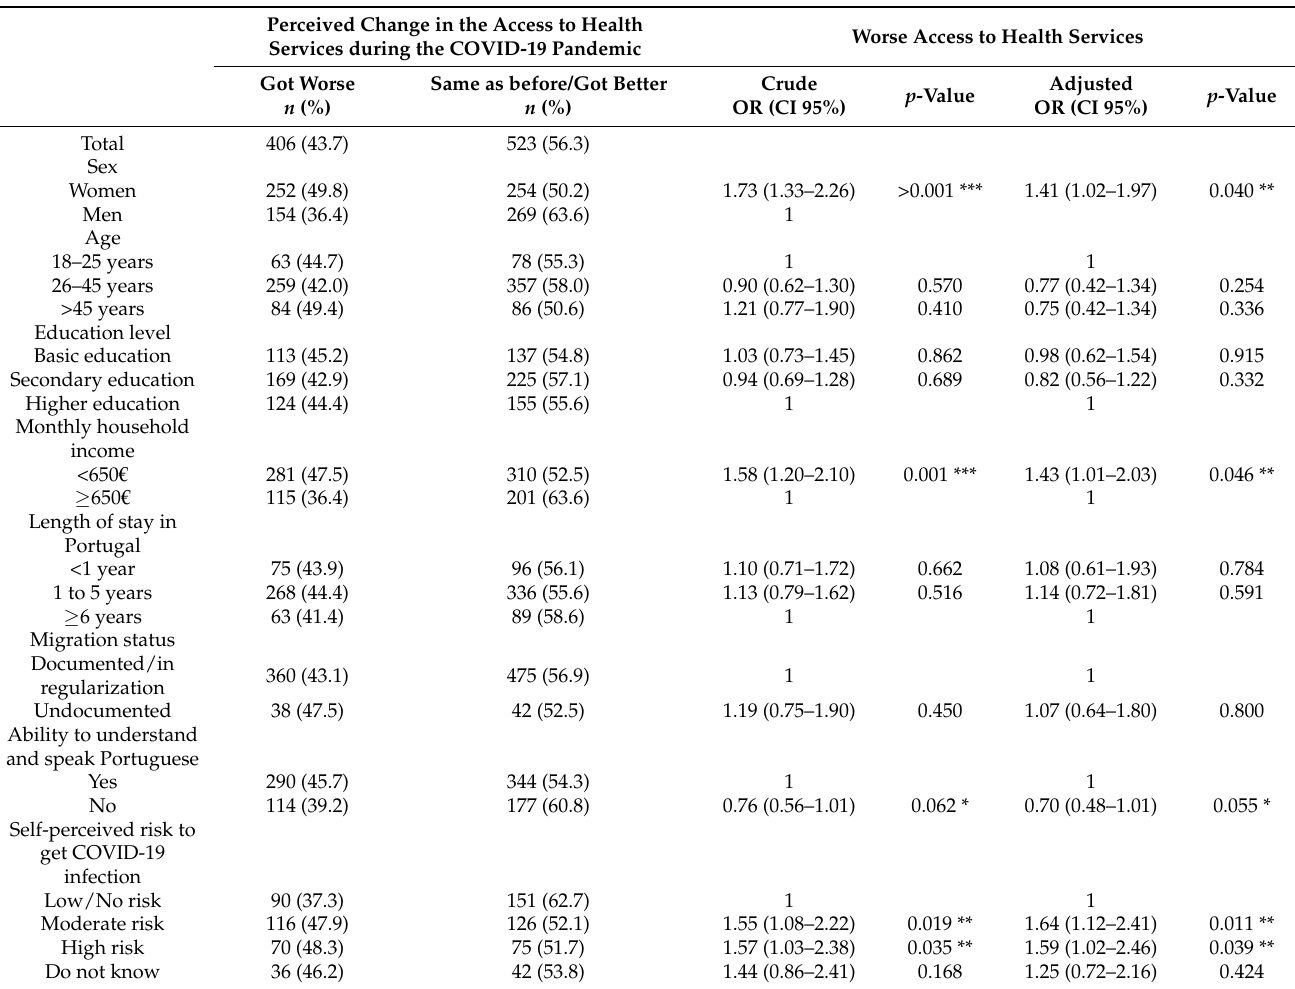
Table 2. Characteristics of the participants by perceived change in the access to health services during the COVID-19 pandemic and factors associated with perceived worsening in access ( n = 929). Perceived Change in the Access to Health Worse Access to Health Services during the COVID-19 Pandemic